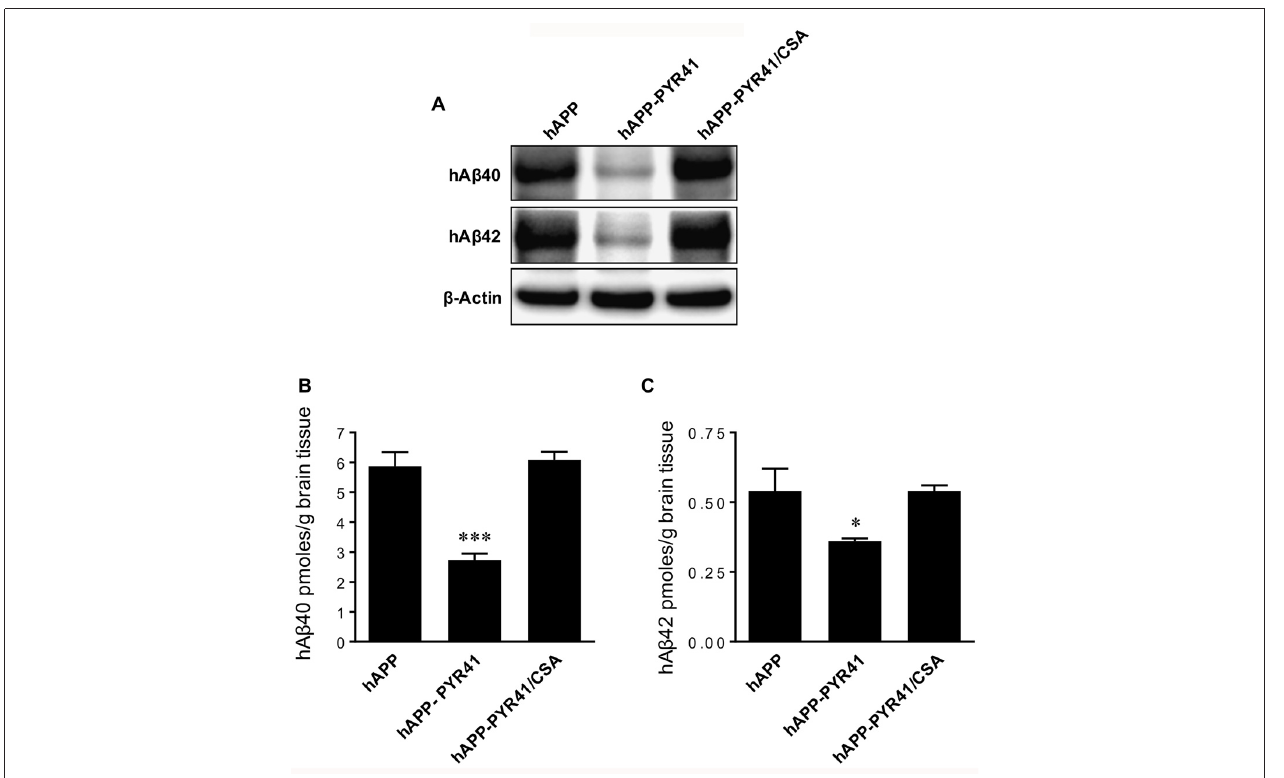
FIGURE 7 | PYR41 treatment reduces A β brain levels in hAPP mice. (A) Western blots showing PYR41 treatment reduced hA β 40 and hA β 42 protein expression levels in total brain tissue in hAPP mice compared to vehicle-treated WT mice or hAPP mice treated with PYR41/CSA; β -actin was used as protein loading control. ELISA analysis of brain tissue revealed that PYR41 significantly reduced protein levels of (B) hA β 40 by 53.3 ± 0.51% and (C) hA β 42 by 33.3 ± 0.08%. Data are mean ± SEM (pooled tissue from 15 mice per treatment group). Statistics: ∗ p < 0.05 and ∗∗∗ p < 0.001 (ANOVA), significantly lower than hAPP vehicle-treated